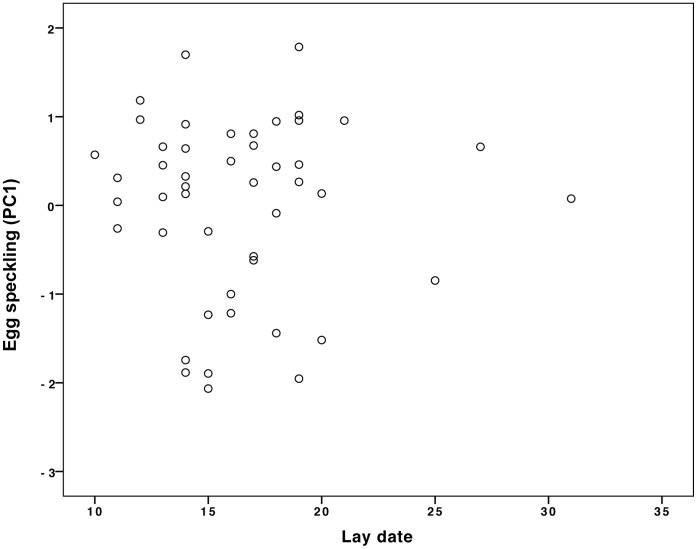
Female lay date had no effect on egg speckling (PC1).N = 47 (see text for statistics). Lay date is the date a female laid her first egg, shown here as the number of days after 31 March 2009.